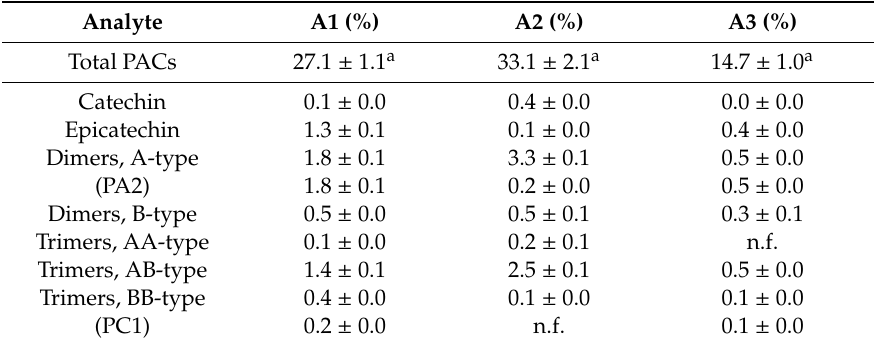
Table 1. Total PACs in Cranberry extracts by DMAC assay and percentage of the main monomers, dimers, and trimers quantified by UHPLC-HR